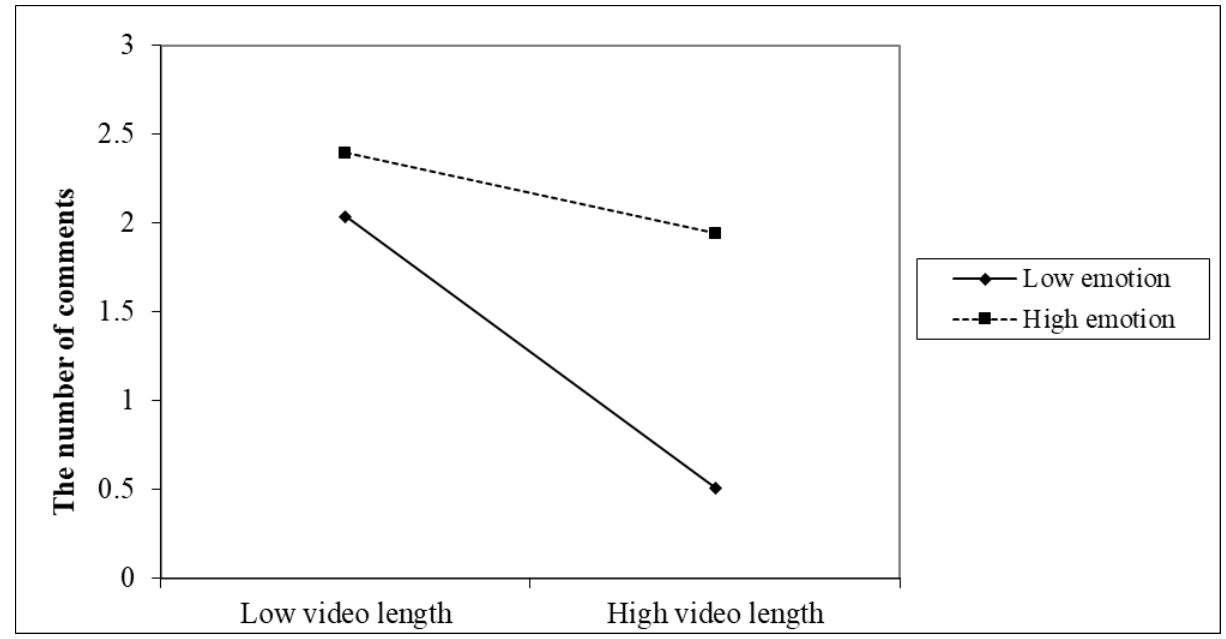
Figure 4. Interaction effects of video length and emotion on the number of comments